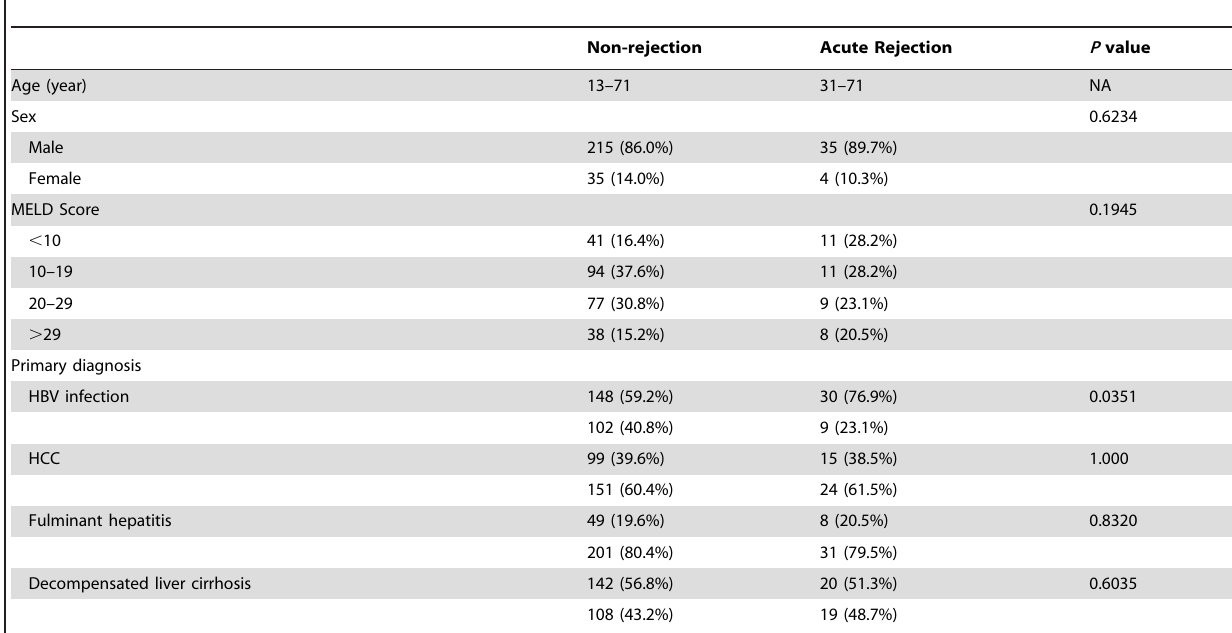
Table 1. Characteristics and primary diagnosis of 289 liver transplantation recipients assigned to a non-rejection or acute rejection